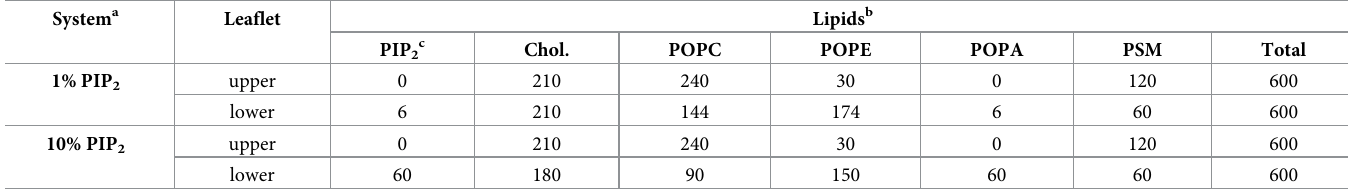
The systems were minimized using the steepest descent algorithm and heated to 293.15 K over 40 ps, and then simulated to 500 ns under constant number, pressure, and temperature (293.15 K) using the Nose´–Hoover thermostat [56]. The integration time step equals 1 fs (for additional accuracy [57]), and coordinate sets were saved every 5 ps. Electrostatics were Table 1. Lipid component numbers in MD